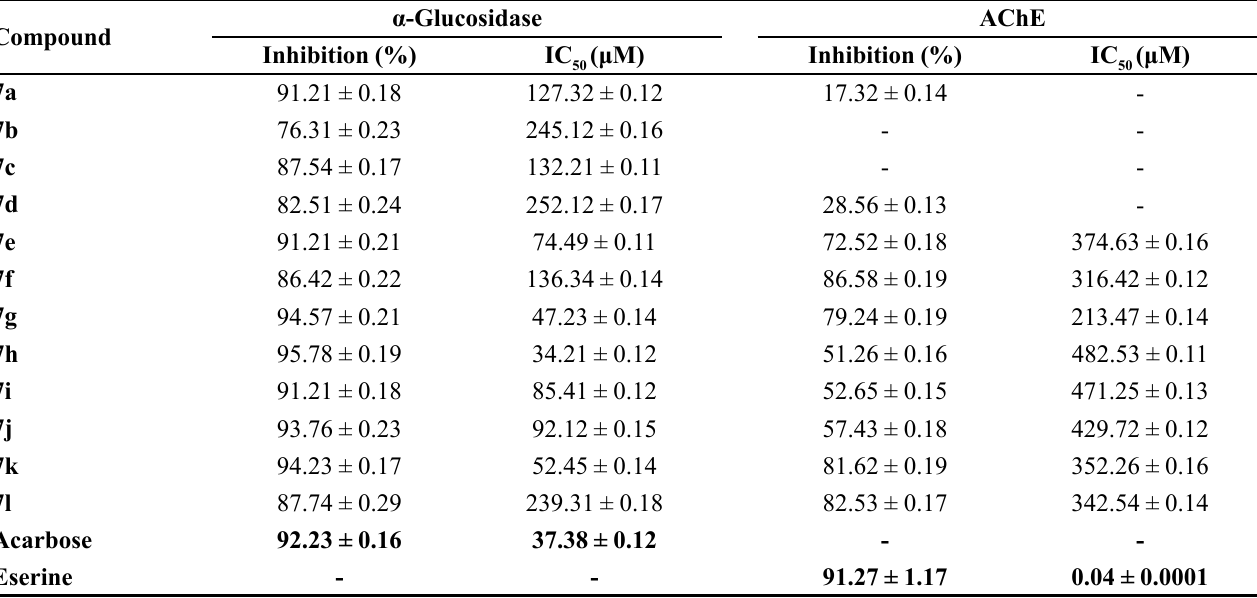
TABLE II - Percent inhibition at 0.5 mM and IC